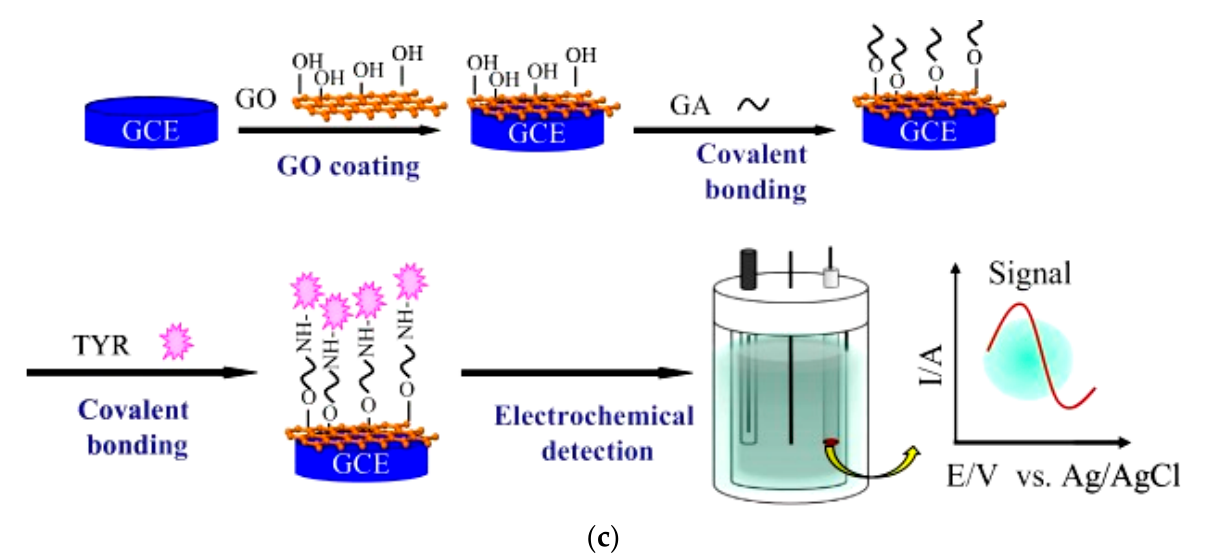
Figure 4. ( a ) Schematic figure of electrochemical biosensor based on the immobilized HRP on Au-Pt nanotube/Au graphene for simultaneous identification of butylated hydroxyanisole (BHA) and propyl gallate (PG); ( b ) SPCE modification with the polypyrrole /laccase/AuNPs nanocomposite for the quantification of polyphenols; ( c ) determination of phenol derivatives based on the tyrosinase immobilization on the surface of GCE modified with graphene oxide. Reprinted with permission from [84,90,93], respectively.